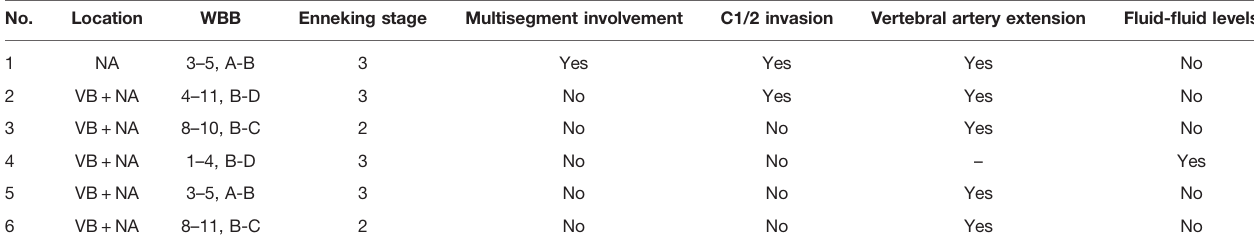
TABLE 4 | Imaging characteristics of recurrence cases. No.